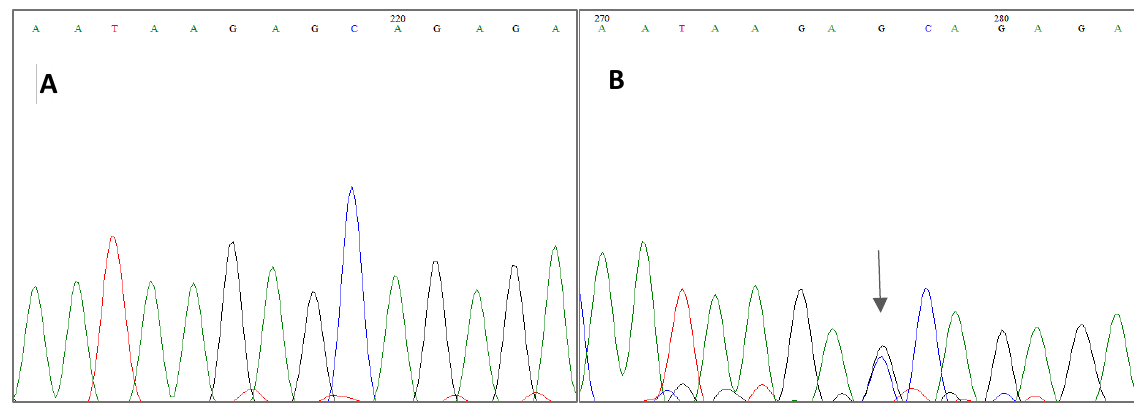
Figure 2. Electropherograms showing sequence without variant (A) and with the new mutation in exon 4 of the IRF6 gene (B). An arrow indicates the altered nucleotide.